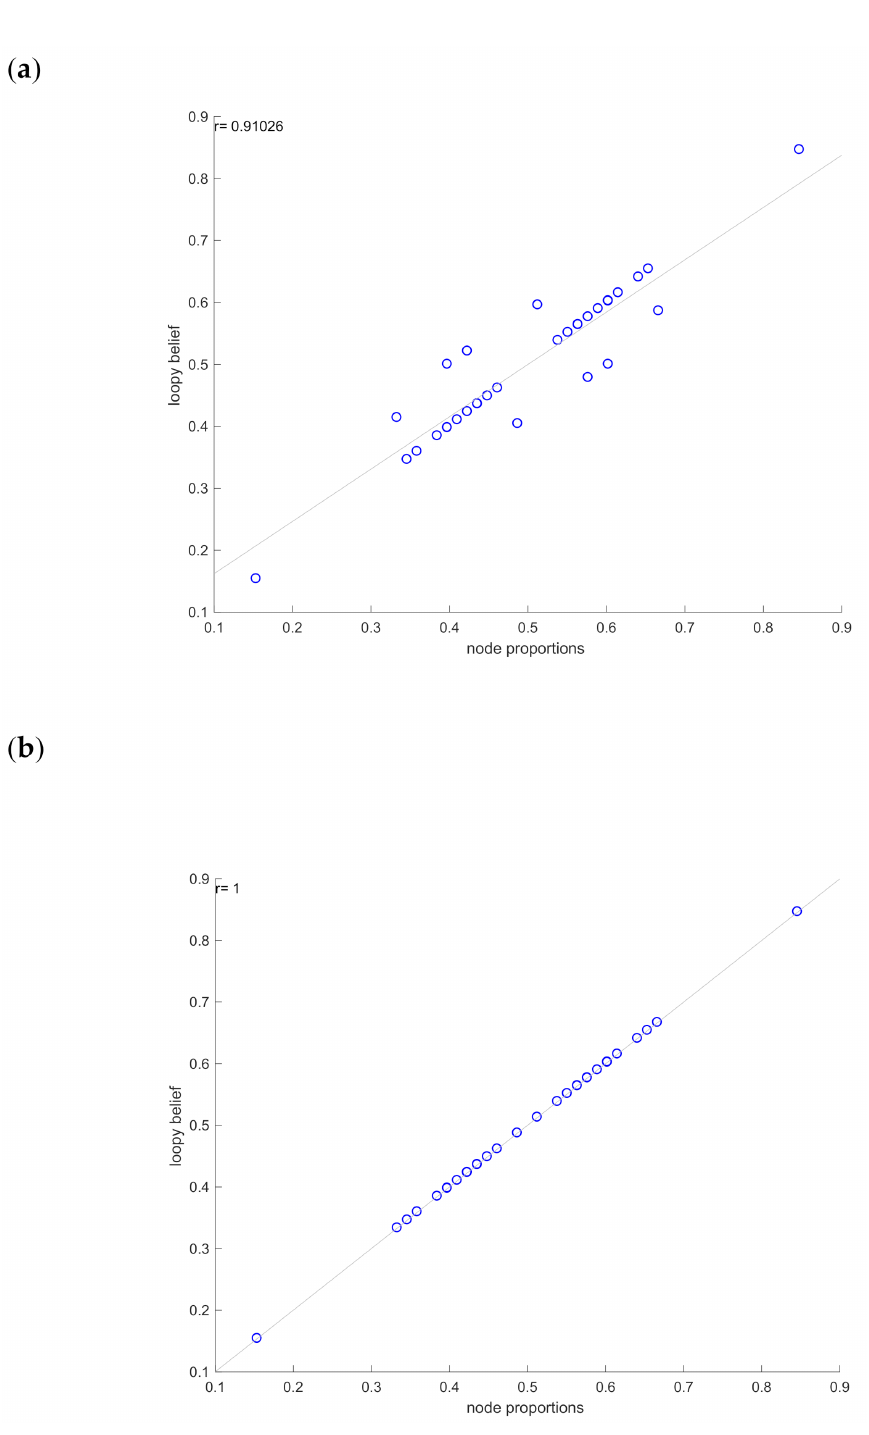
Figure 7. GRNs generated from the application of mutual information distance and entropy reduction (MIDER) on the PDAC dataset. ( a ) GRN with selected edges (95% threshold); ( b ) GRN with selected edges (Combining output of MIDER and